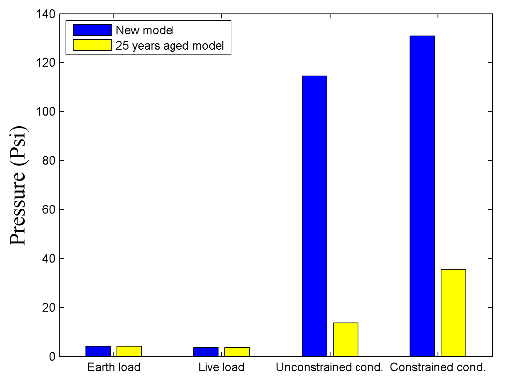
Figure 9. Buckling resistance comparison for new and aged models of PE 100 enclosure regarding their underground implementation.